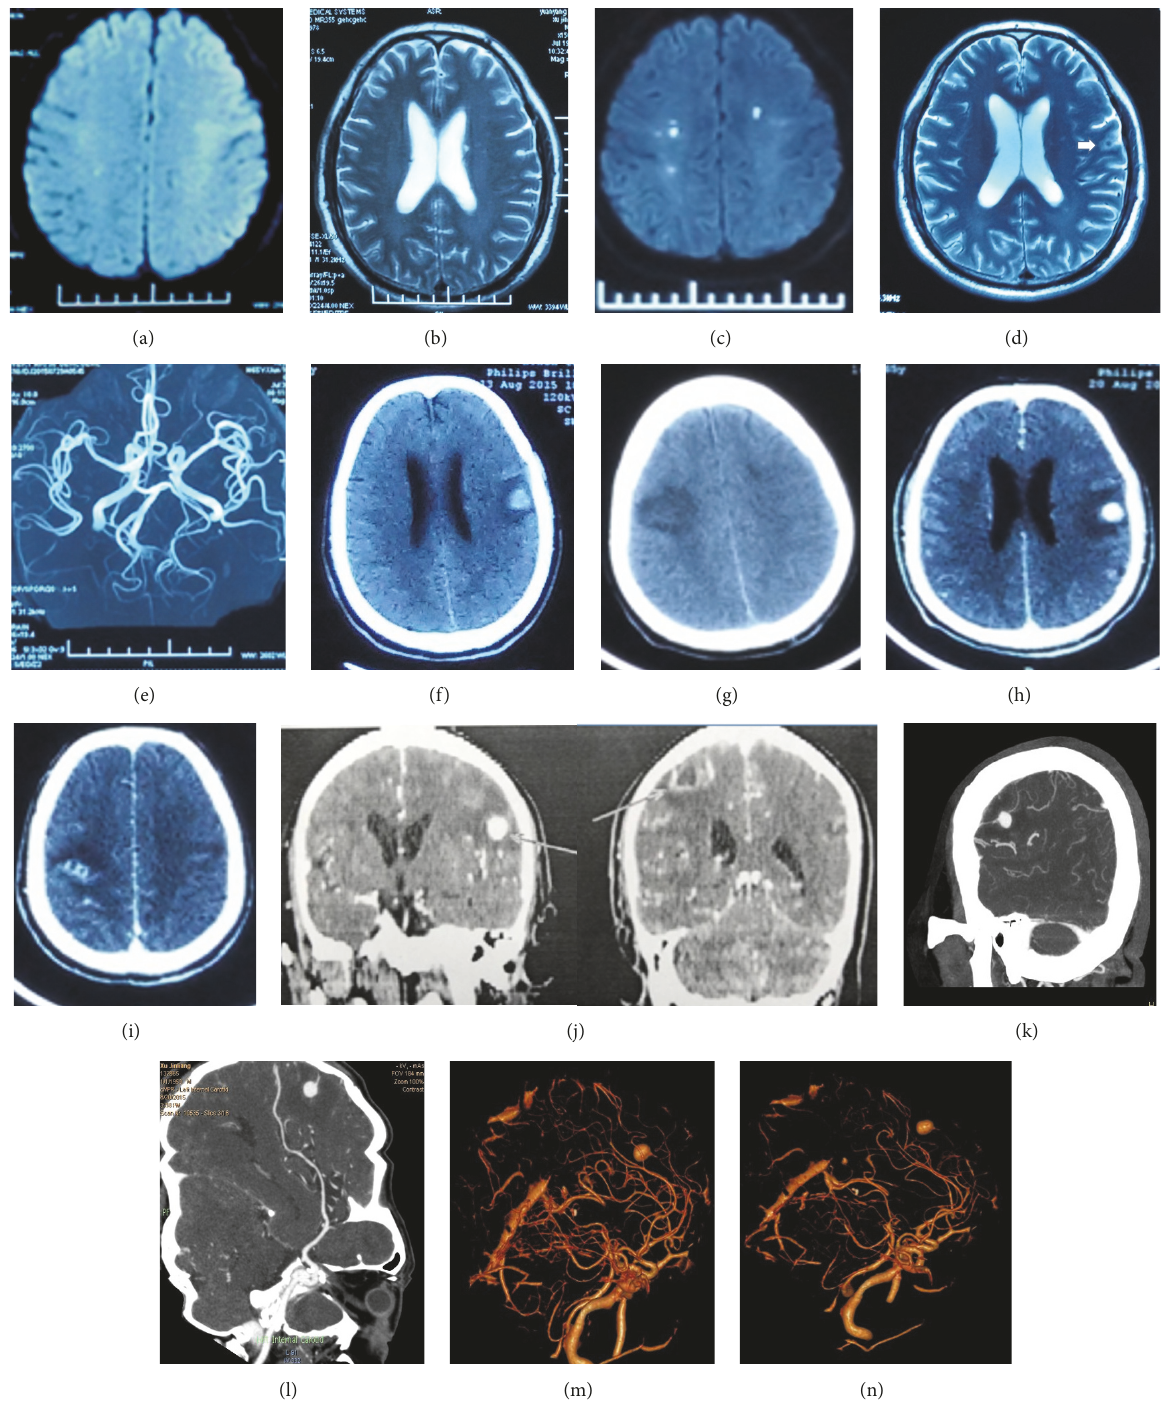
Figure 1: Dynamic changes on brain MRI and CT imaging. ((a) and (b)) On admission, DWI or T2 sequences of MRI showed hyperintense signal intensity in the right centrum semiovale and hyperintense lacunar lesions adjacent to the left lateral ventricle. ((c) and (d)) On day 7 of admission, MRI showed hyperintense signal intensity in the left cerebellar hemisphere, left temporal lobe, and bilateral frontal-parietal lobe. A flow void was found in the left hemisphere (arrow). (e) MRA did not show any abnormality in the intracranial arteries. ((f) and (g)) On day 11 of admission, CT scan revealed high density nodules in the right frontal-parietal region and a low density shadow in the right parietal lobe. ((h)–(j)) On day 20 of admission, Contrast-enhanced CT showed high density nodules surrounded by edema in the left frontal-parietal region and a ring-enhancing nodule in the right parietal lobewith peripheral edema (arrow). ((k)–(n)); CT angiography showed an aneurysm on a cortical branch of the left middle cerebral